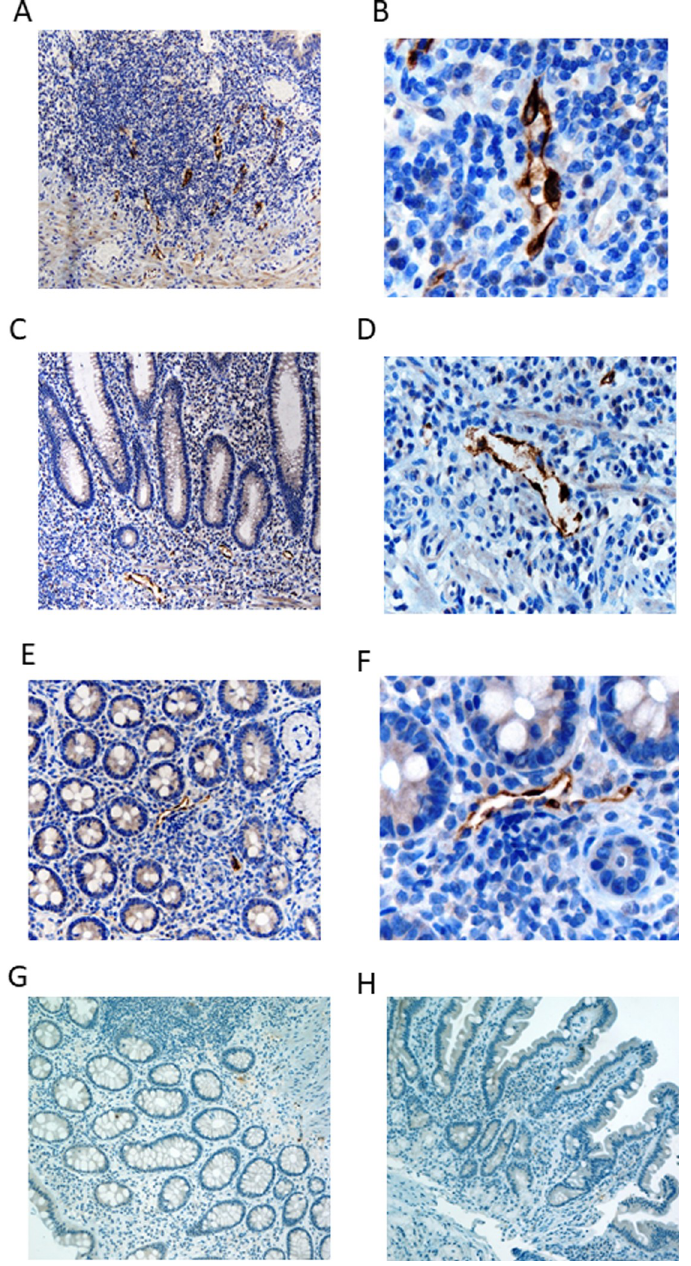
Fig 5. Immunohistology of venule endothelial expression of CCL21 in intestinal mucosal autoimmune diseases. A) 40x magnification of 1 of 3 Crohn’s disease intestinal mucosa biopsy immunohistologically stained with the C8 (anti-CCL21 monoclonal antibody). Two of 3 had similar positive results as shown here. B) 100 x magnification of (A). C) 40x magnification of 1 of 3 ulcerative colitis colonic mucosa biopsy immunohistologically stained with C8. All 3 biopsies had results nearly identical to that show here. D) 100 x magnification of (C). E) 40x magnification of 1 of 6 colonic mucosal biopsies of celiac sprue disease immunohistologically stained with C8. Four of the 6 samples had nearly identical results with that shown here. F) 100 x magnification of (E). (G) Normal duodenal endothelium does not express CCL21. One of 3 biopsy samples shown here that is representative of all 3. H) Normal colonic endothelium does not express CCL21. One representative sample of 3 biopsies shown